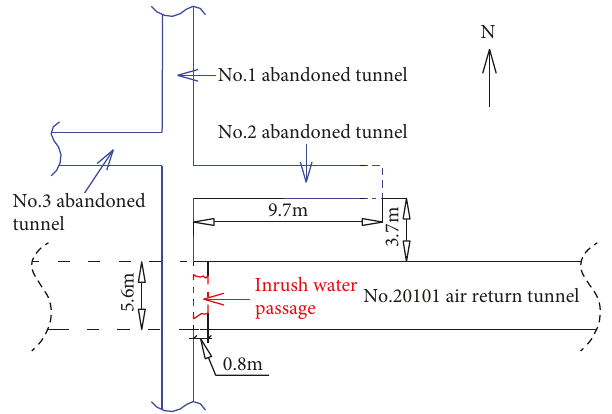
Figure 6: Plane location of the inrush water